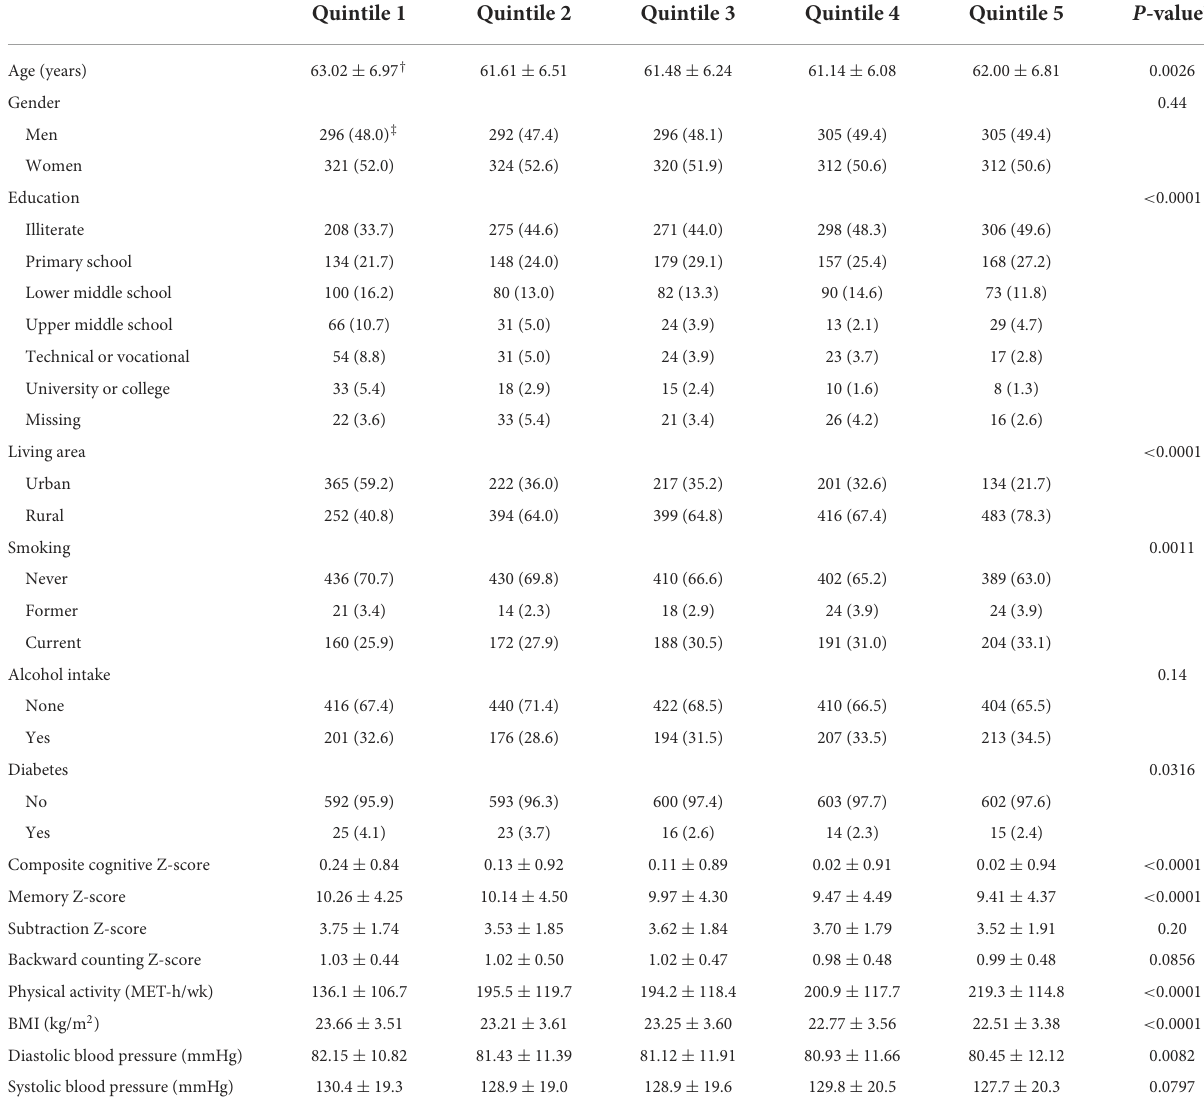
TABLE 1 Baseline characteristics across quintiles of plant protein